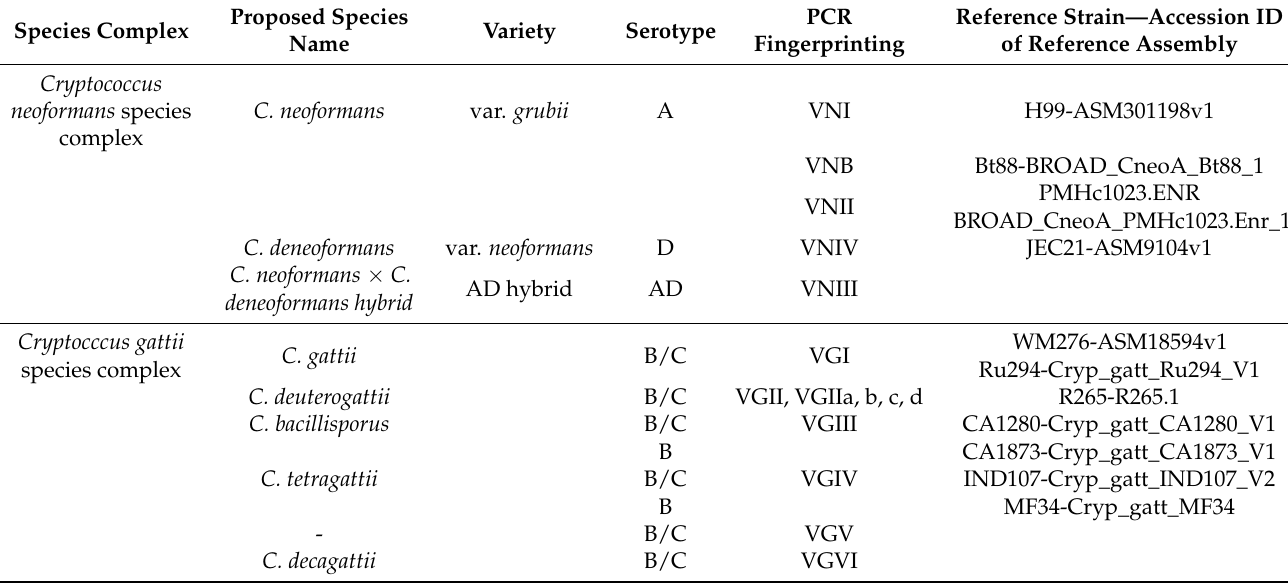
Table 1. Classification of Cryptococcus neoformans and Cryptococcus gattii species complexes based on serotype, molecular sub-type, and genomic